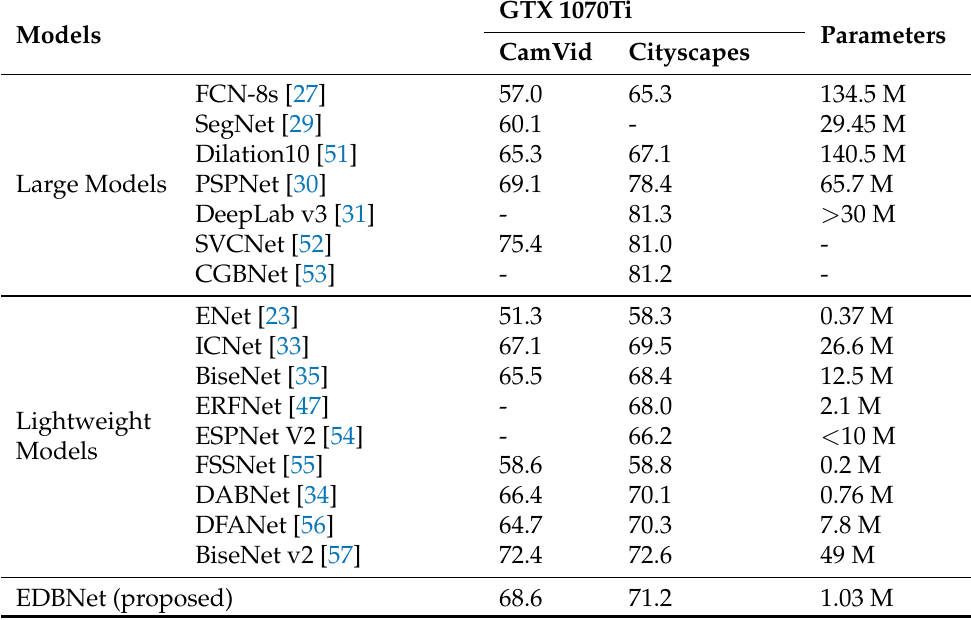
Table 2. Testing Results of Accuracy